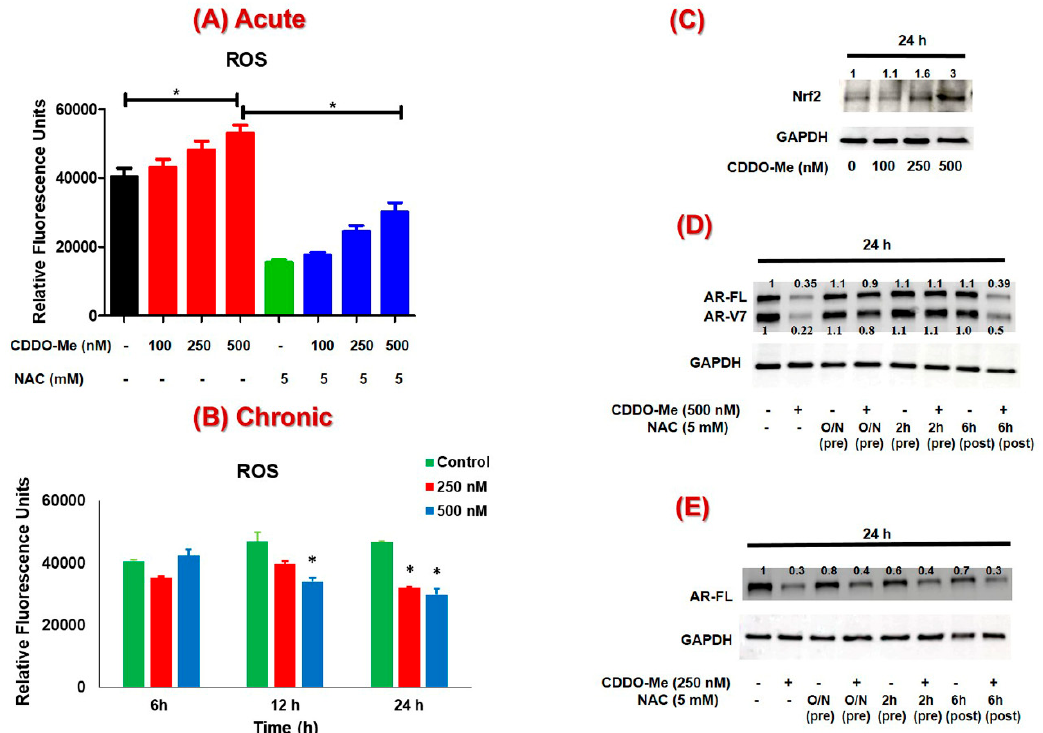
Figure 3. E ff ect of CDDO-Me mediated reactive oxygen species (ROS) on AR levels in PC cells. ( A ) Acute e ff ect of CDDO-Me on ROS levels in 22Rv1 cells. 22Rv1 cells were exposed to CDDO-Me (100, 250, and 500 nM) for 2 h with and without 5 mM N-acetyl cysteine (NAC) (2 h pretreatment) and ROS levels were measured. ( B ) Chronic e ff ect of CDDO-Me on ROS levels in 22Rv1 cells. 22Rv1 cells were treated with CDDO-Me (250 and 500 nM) and ROS levels were detected at 6, 12, and 24 h. The data (% of control) are expressed as the mean ± SEM of three independent experiments ( n = 3) and significant di ff erences between groups are shown as p -values (* p < 0.05) ( C ) E ff ect of CDDO-Me on Nrf2 protein levels. C4-2B cells were treated with increasing doses of CDDO-Me (100, 250, and 500 nM) for 24 h and total Nrf2 and GAPDH levels were detected by immunoblot. In ( D ) and ( E ), CDDO-Me exposure was carried out in cells that were either pretreated (2 h or overnight (O / N)) or posttreated (6 h) with NAC. Cell lysates were obtained at 24 h post CDDO-Me treatment of ( D ) 22Rv1 or ( E ) C4-2B cells. A representative immunoblot of AR and GAPDH protein levels is shown.